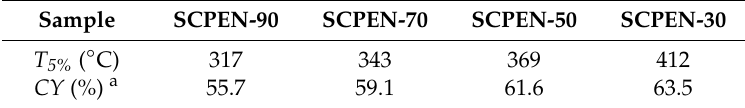
Table 2. Thermal properties of SCPENs